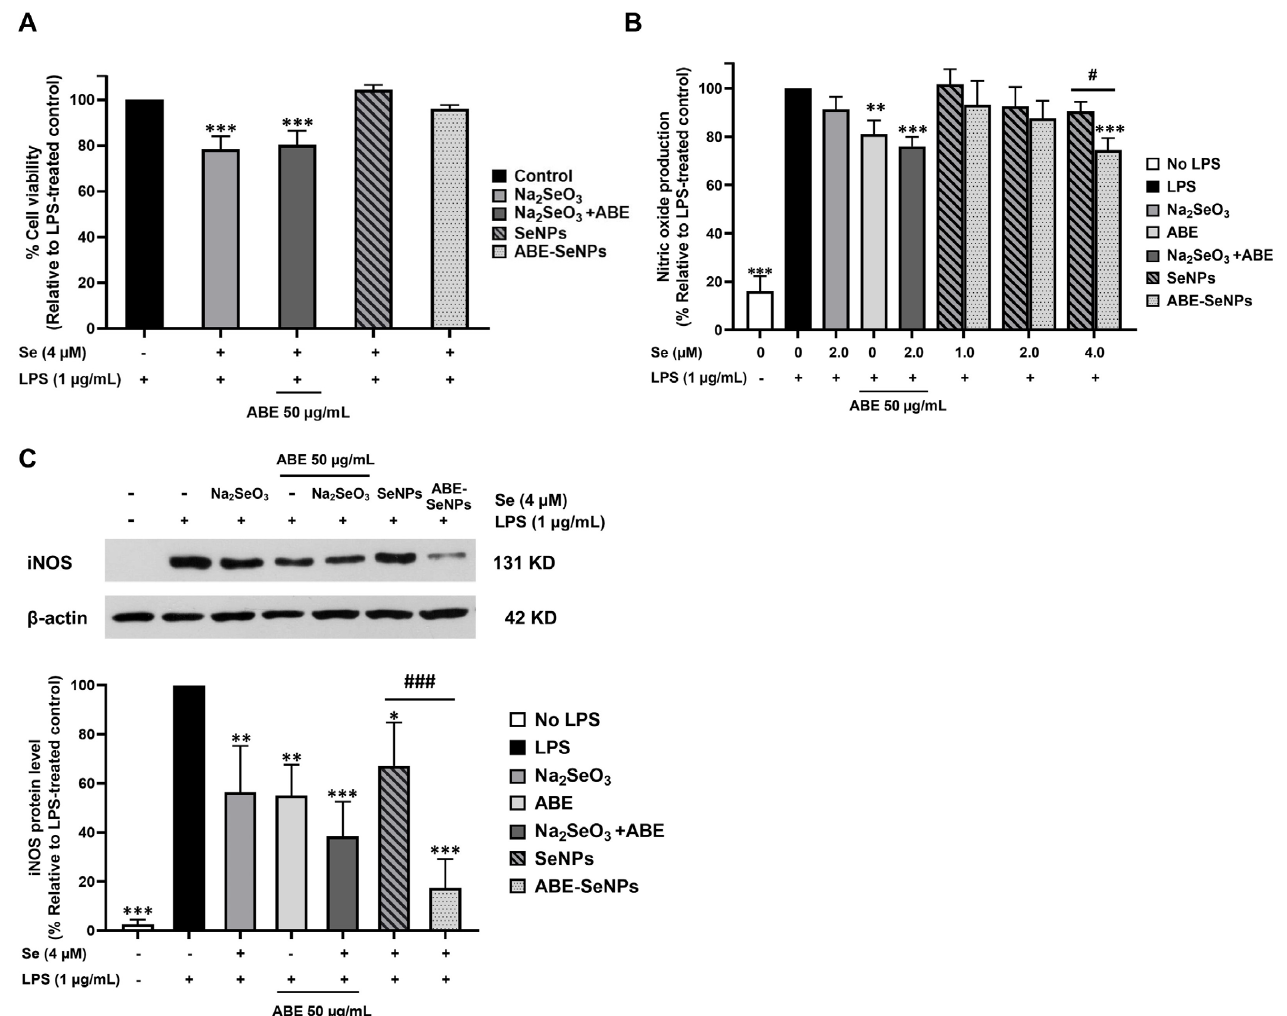
Figure 3. ABE-SeNPs exert anti-inflammation activity. Cell viability of RAW 264.7 macrophages treated with Na 2 SeO 3 , SeNPs, and ABE-SeNPs under the LPS-induced inflammatory condition for 24 h ( A ). Effect of Na 2 SeO 3 , ABE, Na 2 SeO 3 +ABE co-treatment, SeNPs, and ABE-SeNPs on nitric oxide production ( B ) and iNOS protein level (normalized with β-actin) ( C ) in LPS-treated RAW 264.7 macrophages (* p < 0.05, ** p < 0.01, *** p < 0.001 compared to LPS-treated group, # p < 0.05, ### p < 0.01 SeNPs compared to ABE-SeNPs, the data indicated as mean ± SD of three independent experiments).